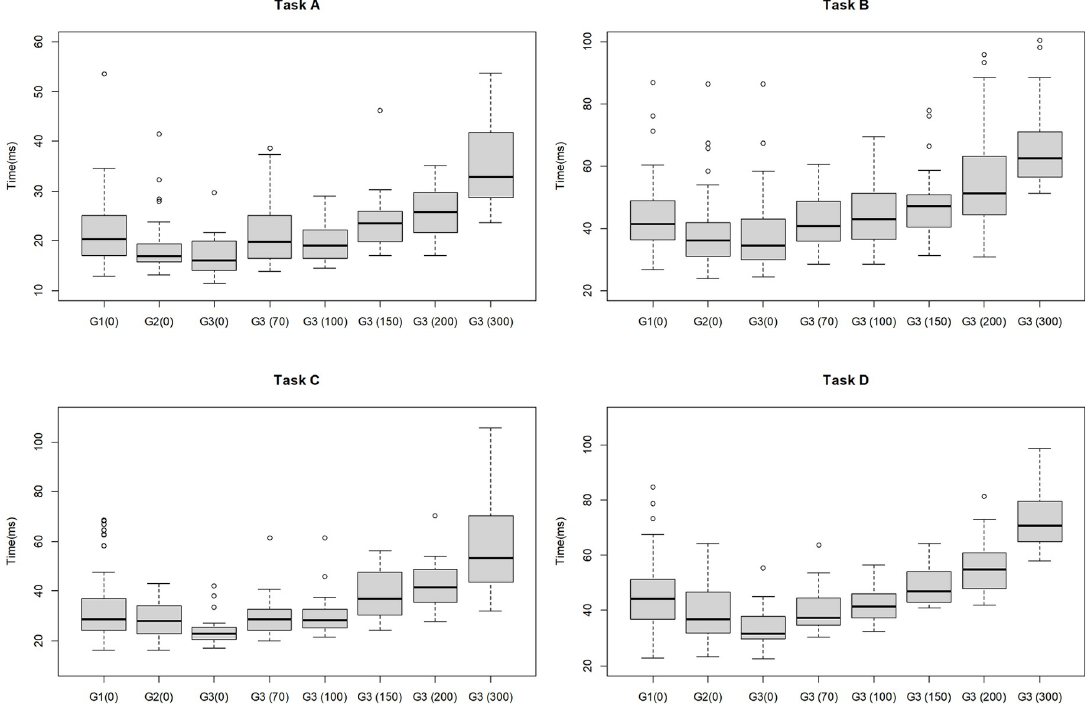
Fig 7. Boxplot of comparing task completion time between Group 3 with delay and Group 1 or Group2 without delay. G1(0), Group 1 without delay; G2(0), Group 2 without delay; G3(0), Group 3 without delay; G3 70, Group 3 with delay of 70 ms; G3 100, Group 3 with delay of 100 ms; G3 150, Group 3 with delay of 150 ms; G3 200, Group 3 with delay of 200 ms; and G3 300, Group 3 with delay of 300 ms.